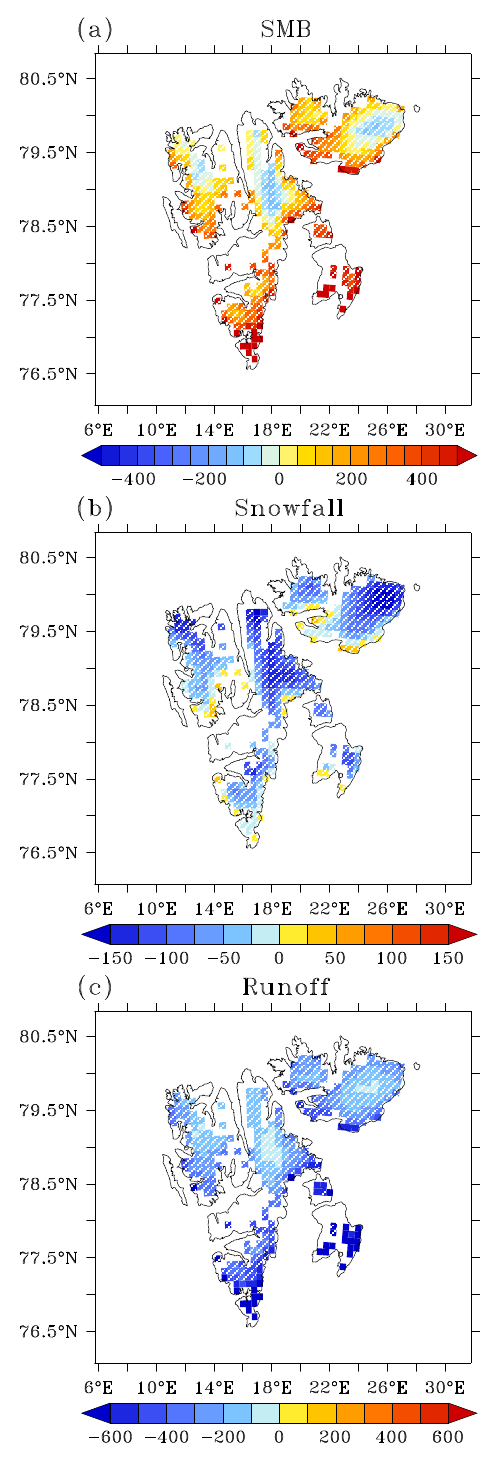
Figure 15. (a) Annual SMB difference (mmw . e . yr − 1 ) between MAR MIROC5 and MAR ERA averaged over 1980–2005. (b) Same as (a) but for the snowfall (mmw . e . yr − 1 ). (c) Same as (a) but for the runoff (mmw . e . yr − 1 ). The non-hatched areas correspond to the areas where the difference is